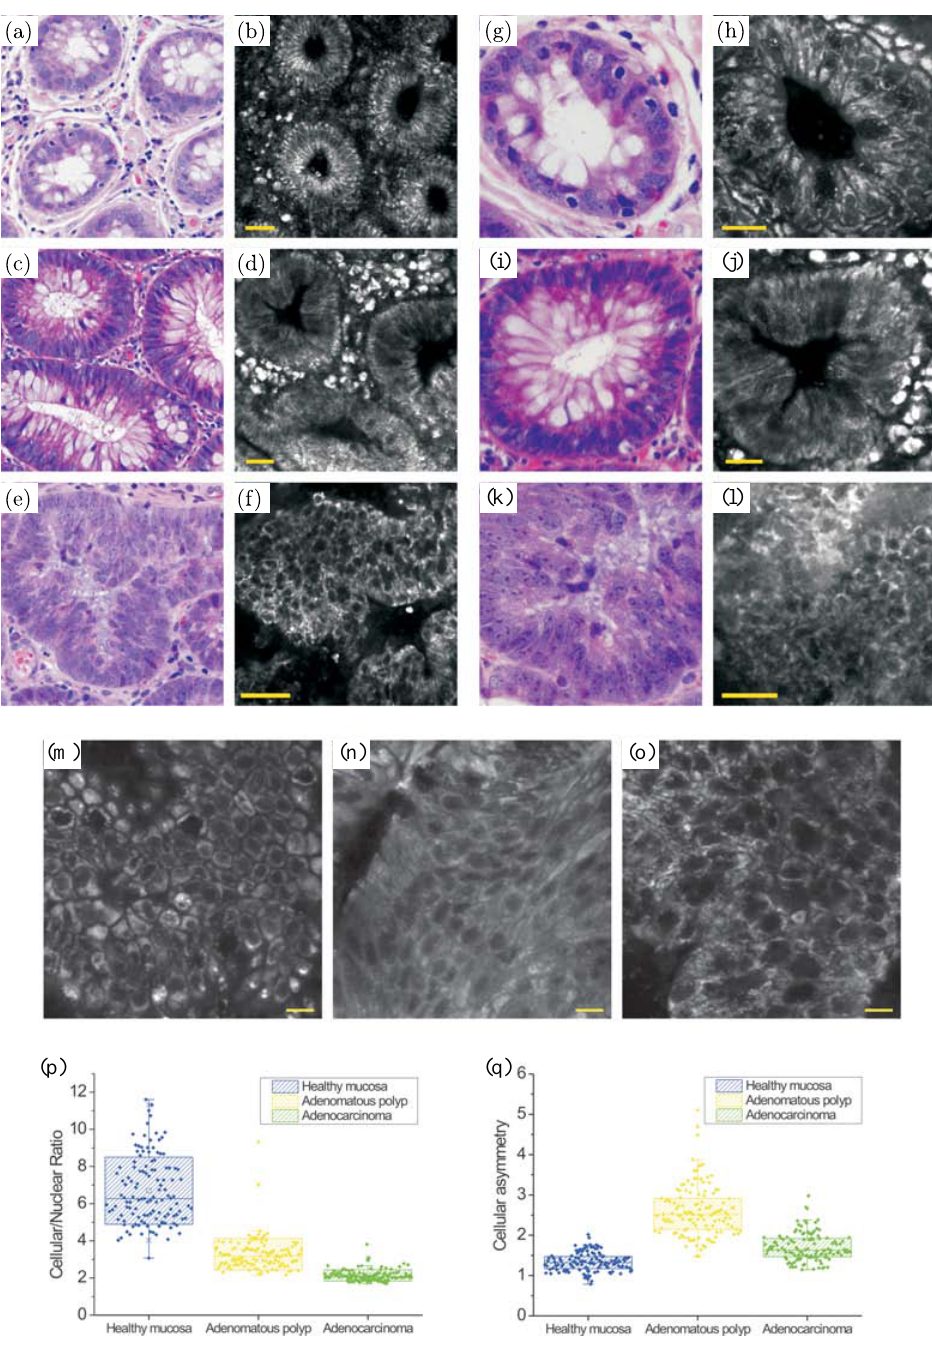
Fig. 1. Histological images taken using a 20X objective on H&E stained tissue sections of healthy colon mucosa (a), adenomatous polyp (c), and adenocarcinoma (e). Corresponding TPF images (taken with a 20X objective – 0.9 NA) acquired from ex vivo fresh biopsies of healthy colon mucosa (b), adenomatous polyp (d) and adenocarcinoma (f). Scale bars: 40 (cid:1) m. Histological images taken using a 40X objective on H&E stained tissue sections of healthy colon mucosa (g), adenomatous polyp (i), and adenocarcinoma (k). Corresponding TPF images (taken with a 40X objective – 1.3 NA) acquired from ex vivo fresh biopsies of healthy colon mucosa (h), adenomatous polyp (j) and adenocarcinoma (l). Scale bars: 30 (cid:1) m. TPF images at high resolution (taken with a 40X objective — 1.3 NA) of healthy colon mucosa (m), adenomatous polyp (p) and adenocarcinoma (o) acquired at 30 (cid:1) m depth from tissue surface on ex vivo fresh biopsies. Scale bars: 10 (cid:1) m. (p) Distribution of the cellular/nuclear size ratio for healthy mucosa, adenomatous polyp and adenocarcinoma. (q) Distribution of the cellular asymmetry for healthy mucosa, adenomatous polyp and adenocarcinoma. In the graphs, dots represent single data points, while the box is enclosing the data within standard deviation. Figure modi¯ed from Ref. 107.